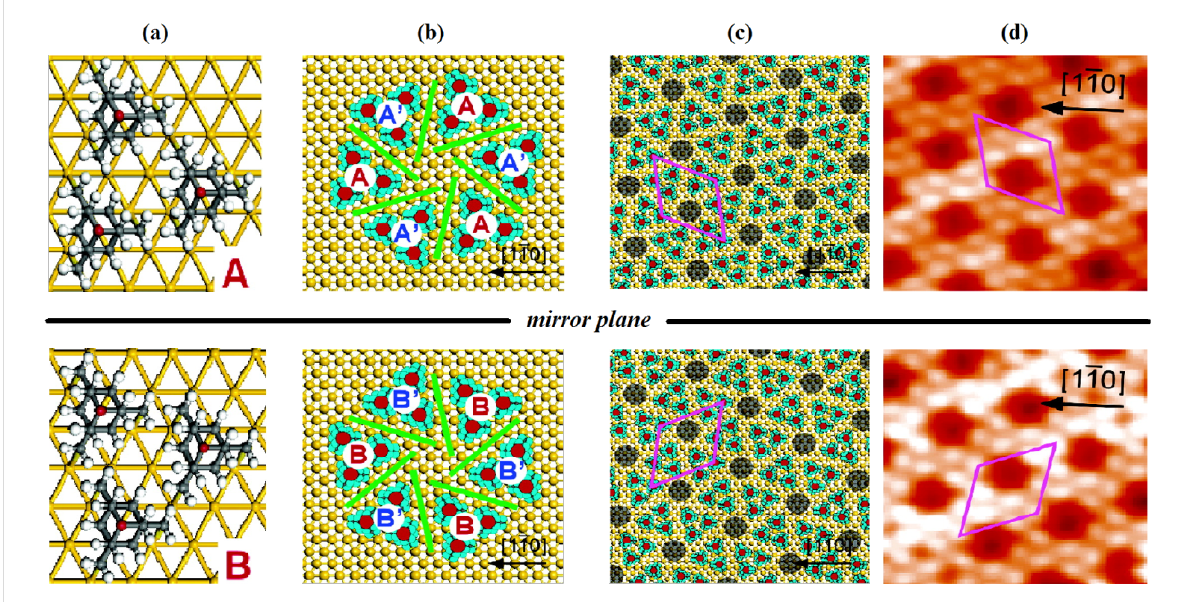
Figure 9: Schematic adsorption models of trimers (a), hexagon (b) and SAMs (c) of 17 on Au(111). B (B’) is the enantiomer of A (A’), the mirror plane of which is aligned parallel to the [1 − 10] direction. 180°-rotated configuration of A (B) is presented as A’ (B’). The chiral components of the trimers are indicated as A, A’, B, and B’. The hierarchical assembly is passed from trimer (a) to hexagon (b) and then to SAMs (c). Each enantiomeric hexagon is composed of the same chiral trimers as shown in (b). The unit cells of the SAMs are indicated in (c), whose periodicities are represented as for A and for B. (d) Corresponding STM images of monolayer SAMs (0.079 ML; 1 ML corresponds to the number of metal atoms on the bulk metal surfaces) ( V s = − 0.8 V, I t = 0.3 nA). Reprinted with permission from [86], copyright 2007 American Chemical